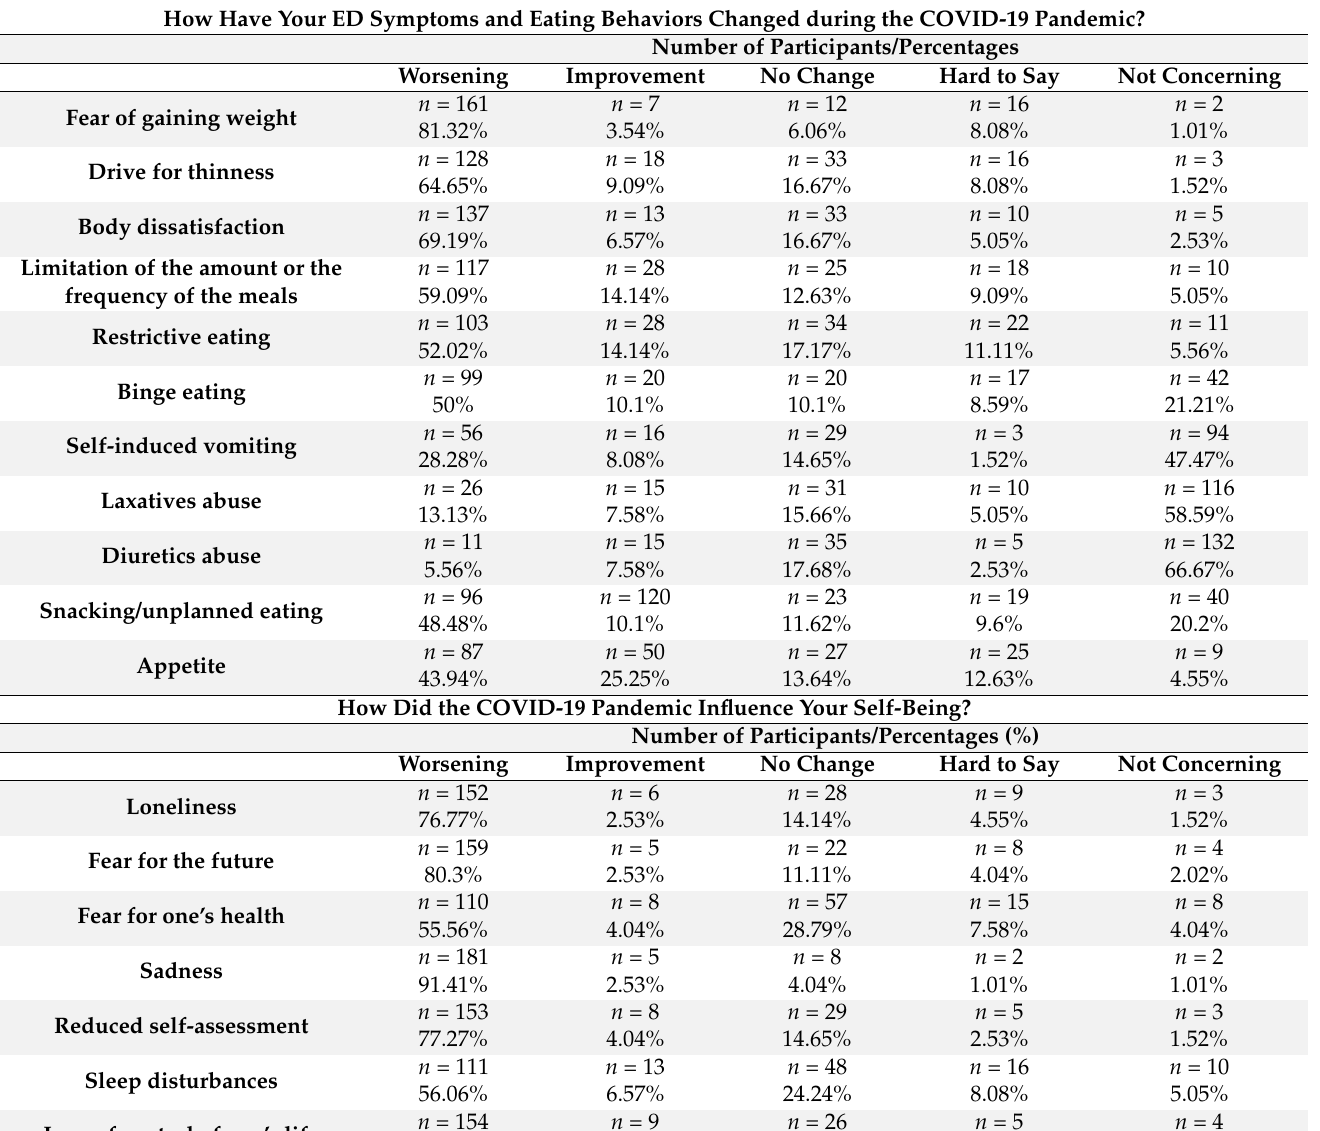
Table 2. Pandemic impact on ED symptoms and general psychopathology symptoms.